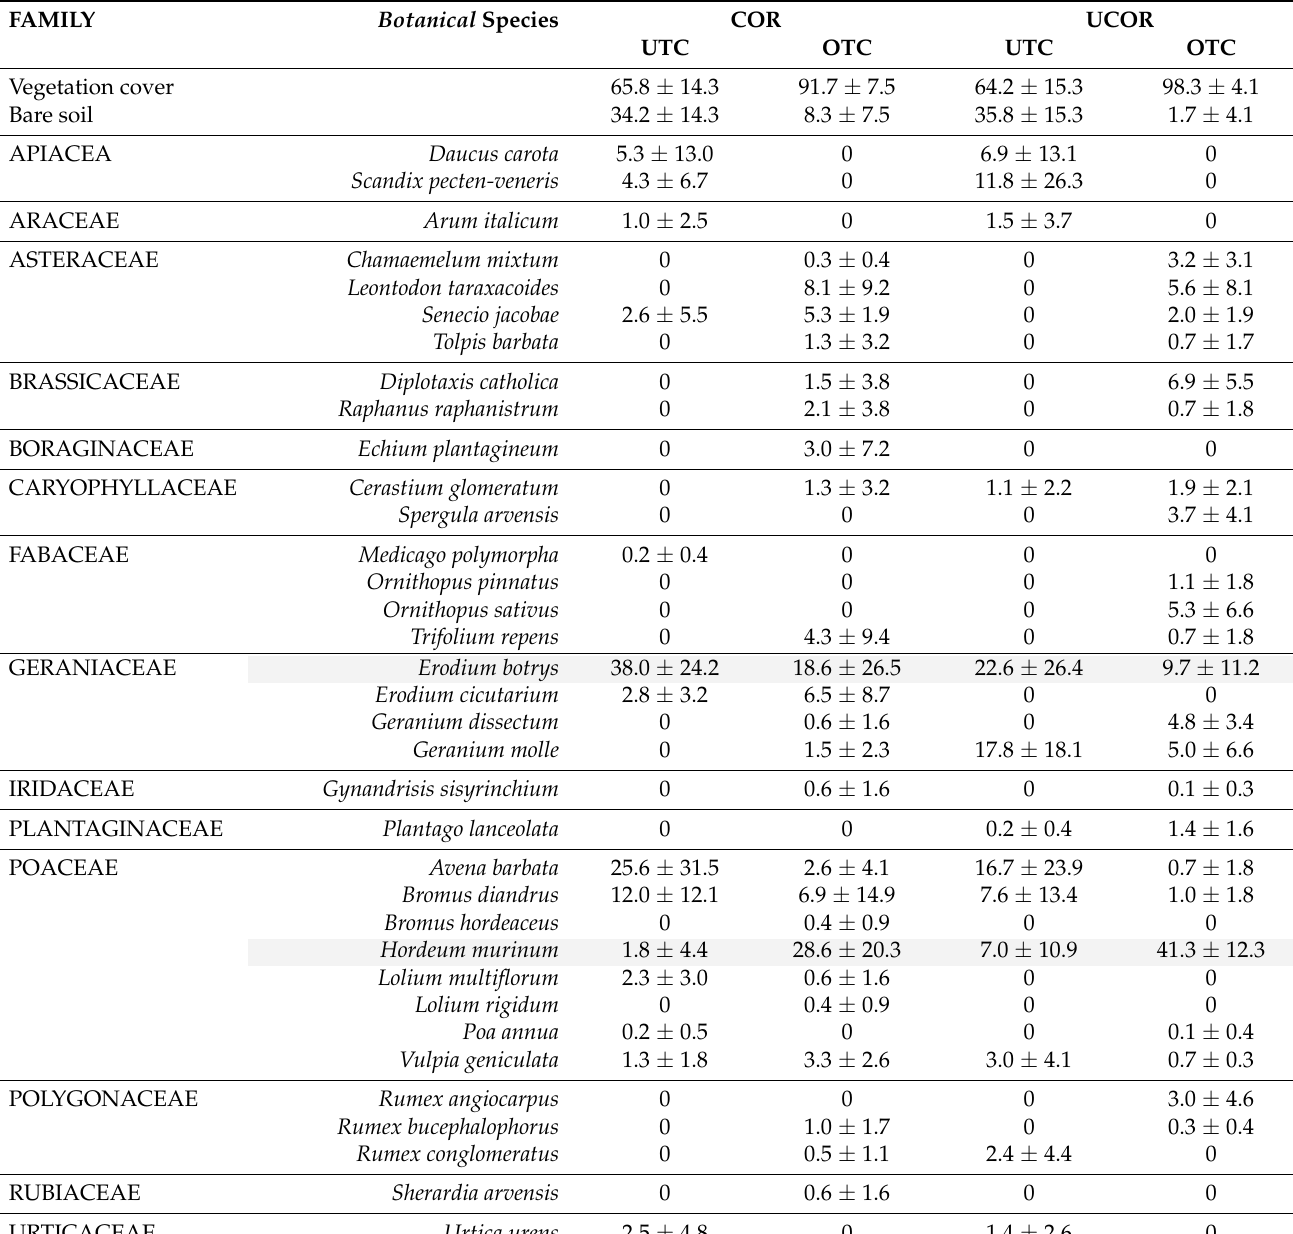
Table 3. Floristic composition (botanical species and family mean cover, %) of pasture of the experimental field in